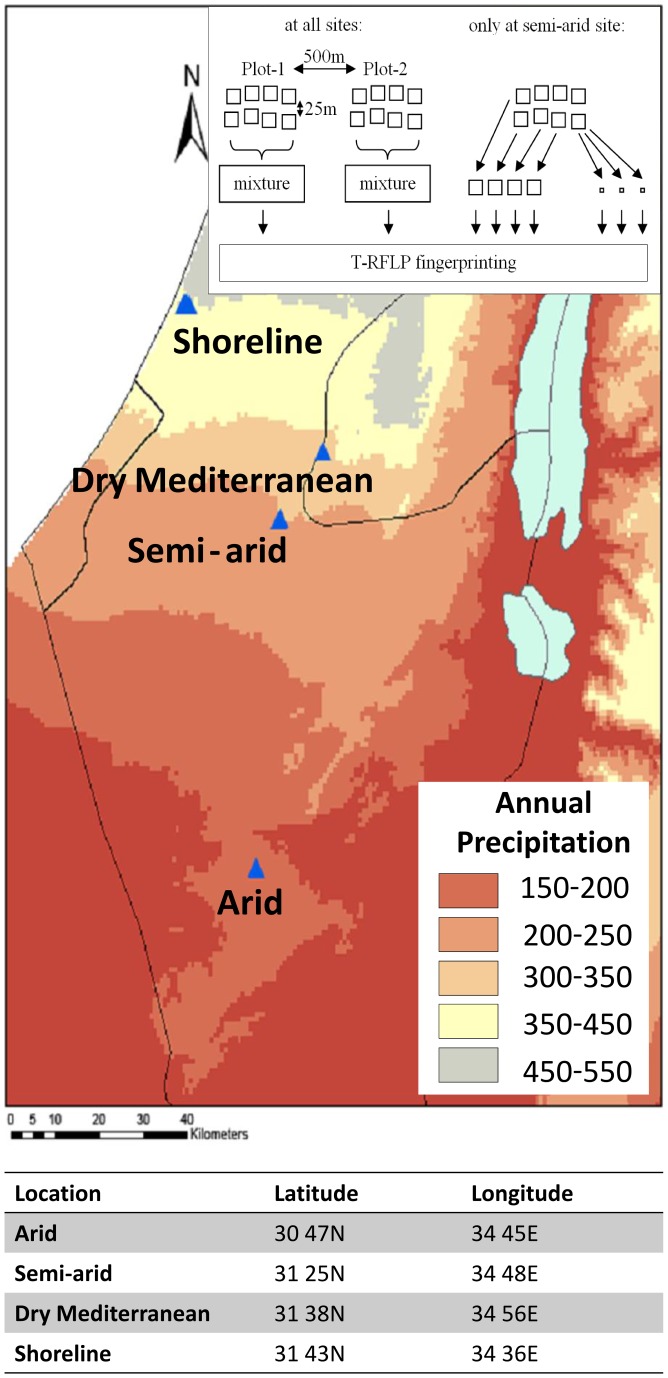
Long term ecological research (LTER) sites and the annual precipitation for the year 2009.Two replica plots were sampled in each of the arid, semi-arid and dry Mediterranean sites; in the shoreline site, five plots were sampled, representing three distinct soil types at close proximity. Additionally, at the semi-aris site, fingerprints of subsamples were also studied. Map and precipitation data from www.usgs.gov.